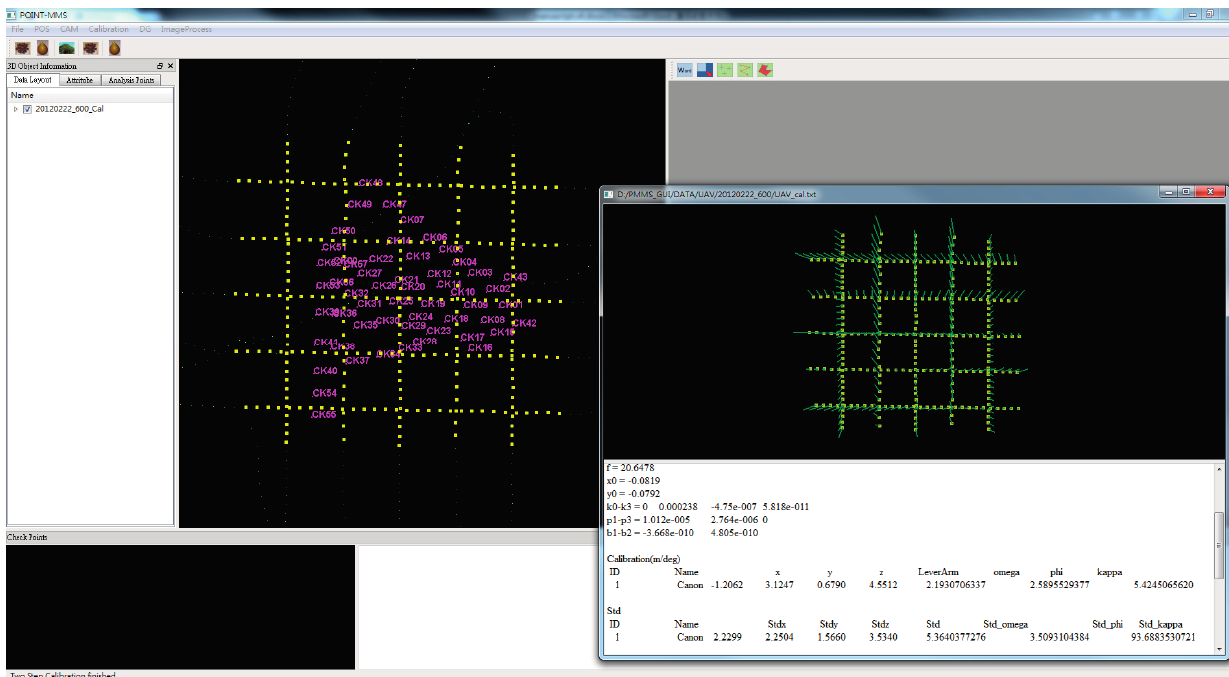
Figure 21. The calibration operation of the